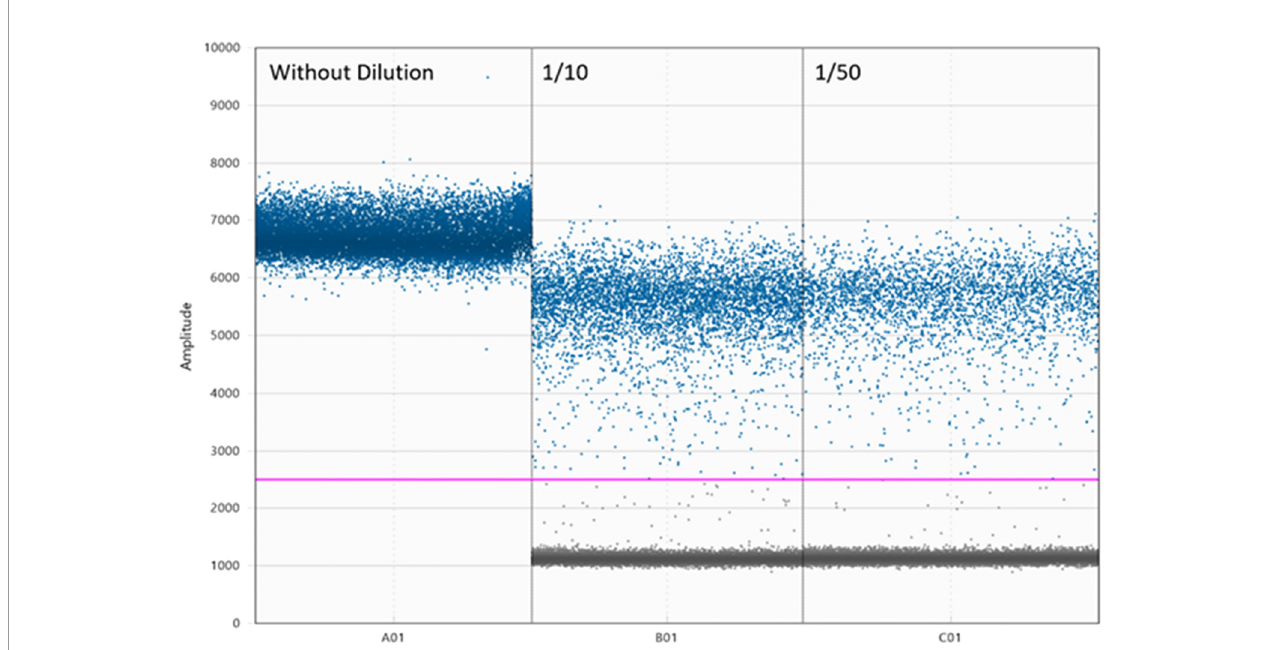
FIGURE 3 | Optimization of DigiMir pipeline. Best separation of positive and negative droplets in the hsa-miR-371a-3p TCam-2 positive control with 1:50 dilution. Notice that there is no separation of droplets in the undiluted